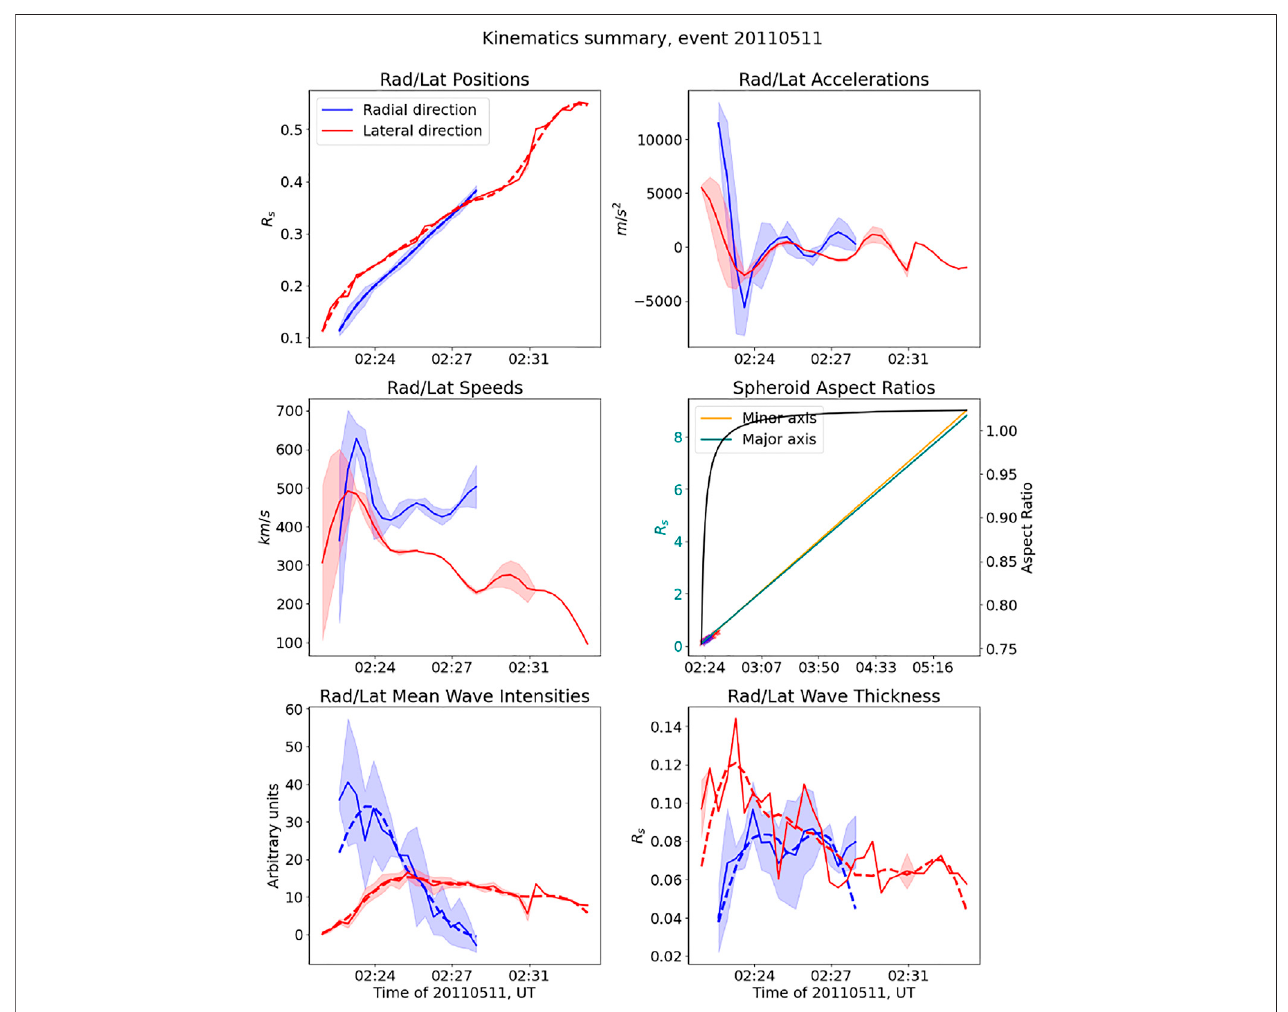
FIGURE 3 | Radial and lateral kinematics of the May 11, 2011 SPREAdFAST event. Shown are the radial (in blue) and lateral (in red, mean of the northward and southwarddirections)time-dependentfrontpositions,aswellascalculatedspeedsandaccelerations.Alsoshownarethemeanintensities(calculatedasthemeanvalue of the intensity in the J-maps between the SPREAdFAST-determined front and back of the CBFs) at each time step. The CBF thickness in each measurement and direction is also calculated from the automatically determined front and back of the